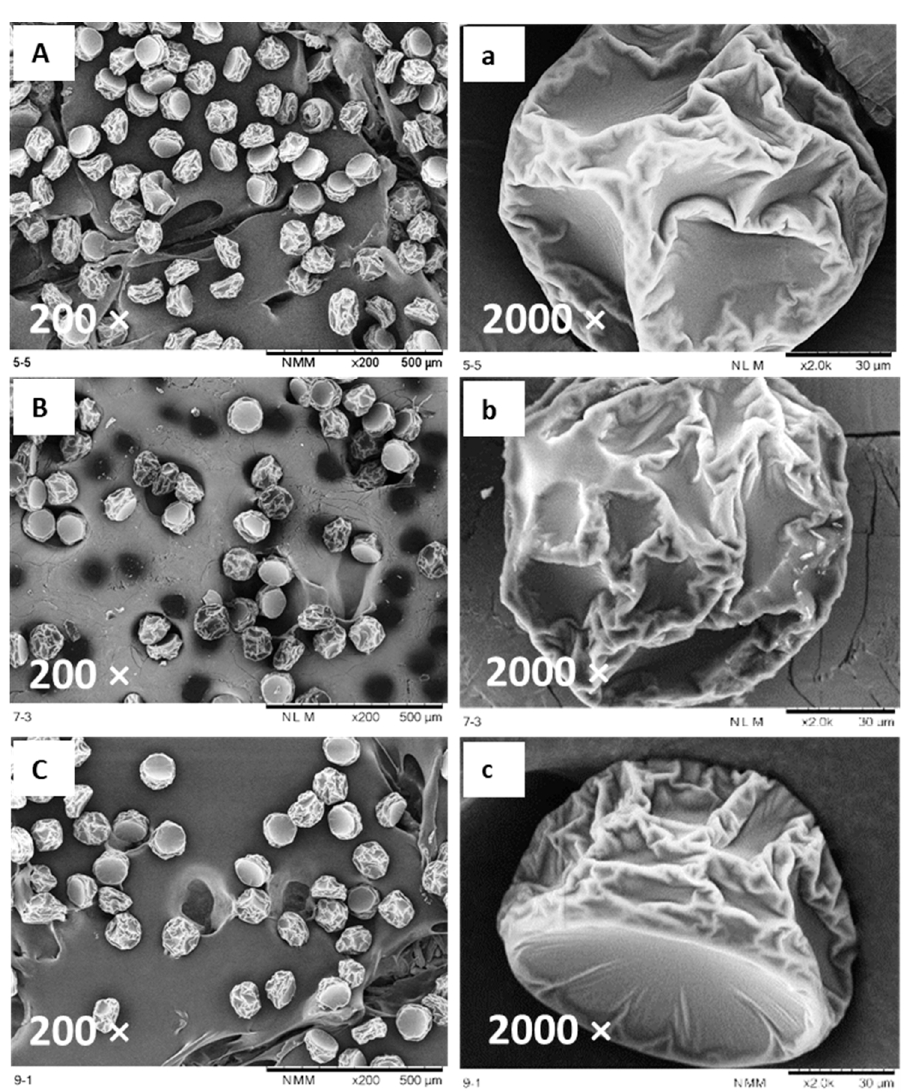
Figure 1. Scanning electron microscopy (SEM) micrographs of microcapsules (( A ), ( a ): P55; ( B ), ( b ): P73; ( C ), ( c ): P91) at 200× and 2000×